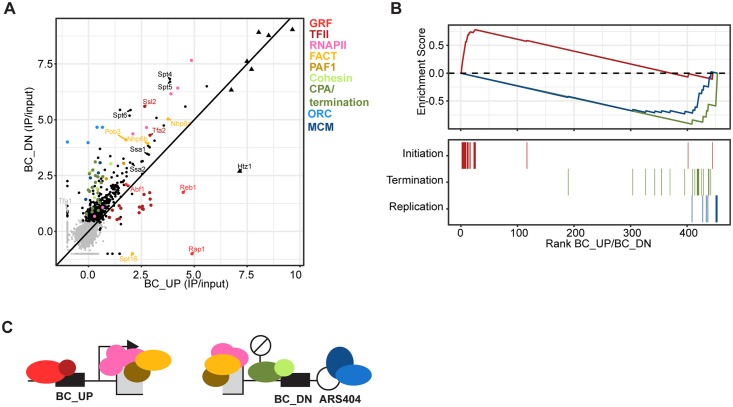
Capturing the chromatin interactome with Epi-Decoder.(A) Scatter plot of ChIP/input values, which can be interpreted as binding scores, of BC_UP versus BC_DN. For some factors, only the BC_UP or BC_DN value was available. In these cases, the missing value was set to −1 in order to still visualize the remaining value. Factors are coloured based on known functions or complexes. Triangles represent histone proteins. The average values of 6 replicates are shown. (B) Enrichment plot for 3 categories: initiation (TFIID-E and GRFs), termination (Cleavage and Polyadenylation and THO complex), and replication (ORC and MCM) factors. Binders were ranked based on the BC_UP/BC_DN ratio. The top part shows the running sum enrichment for each category. Initiation factors were significantly enriched at BC_UP (p = 3.18−3) and termination and replication at BC_DN (p = 2.03−7 and p = 1.06−5). The bottom lines indicate the factors represented in the categories. (C) Illustration of the different protein complexes that Epi-Decoder identified at the barcoded KanMX gene at the HO locus. BC_DN, downstream barcode; BC_UP, upstream barcode; ChIP, chromatin immunoprecipitation; GRF, general regulatory factor; IP, immunoprecipitation; MCM, minichromosome maintenance; ORC, origin recognition complex.